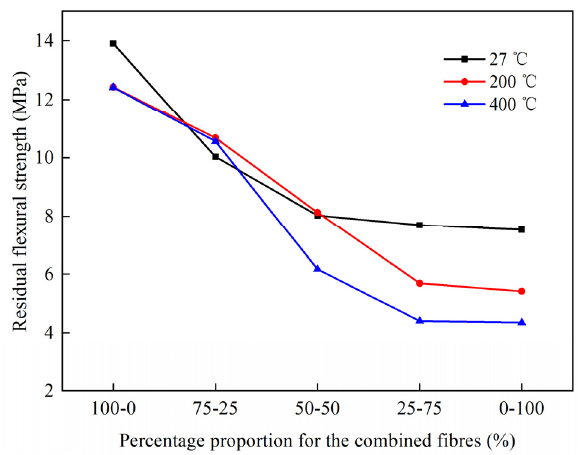
Figure 4. Residual flexural strength of fiber-reinforced concrete (FRC) [56].